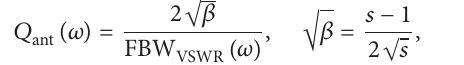
Figure 5. Simulations are conducted using the transient